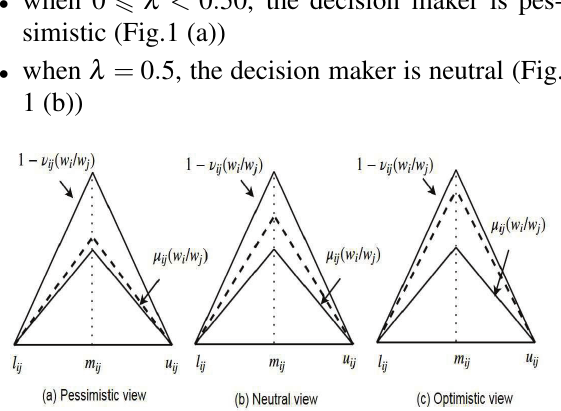
Fig. 1. Decision makers different view